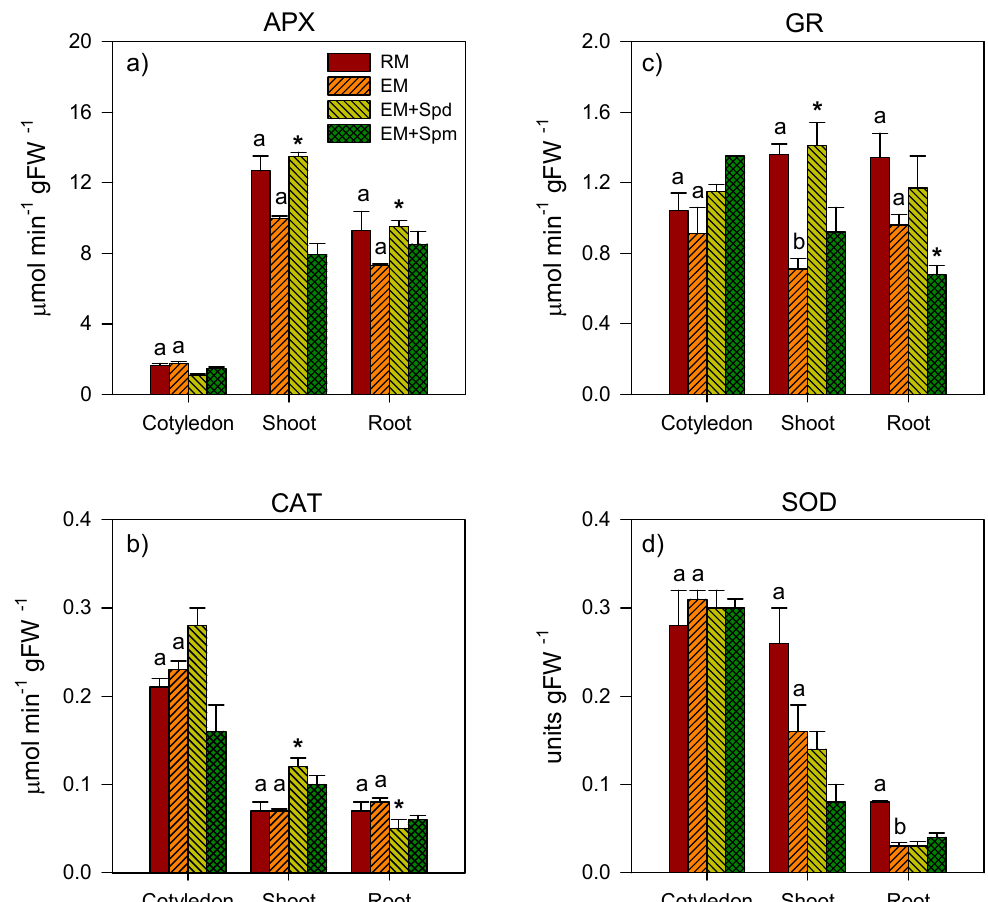
Figure 7. Antioxidative enzyme activity in the tissues of 7 DAP seedlings. Activities of ascorbate peroxidase (APX) (a), catalase (CAT) (b), glutathione reductase (GR) (c) and superoxide dismutase (SOD) (d) in the cotyledon, shoot and root tissues of seedlings under regular watering (RM) and excess moisture (EM) conditions, with or without seed treatment with spermidine (EM + Spd) or spermine (EM + Spm). Data are the means ± SE, n = 2 to 3. Different letters indicate significant differences in enzyme activity between the RM and EM while asterisks (*) indicate significant difference between the EM and EM + Spd or EM + Spm, p ≤ 0.05.